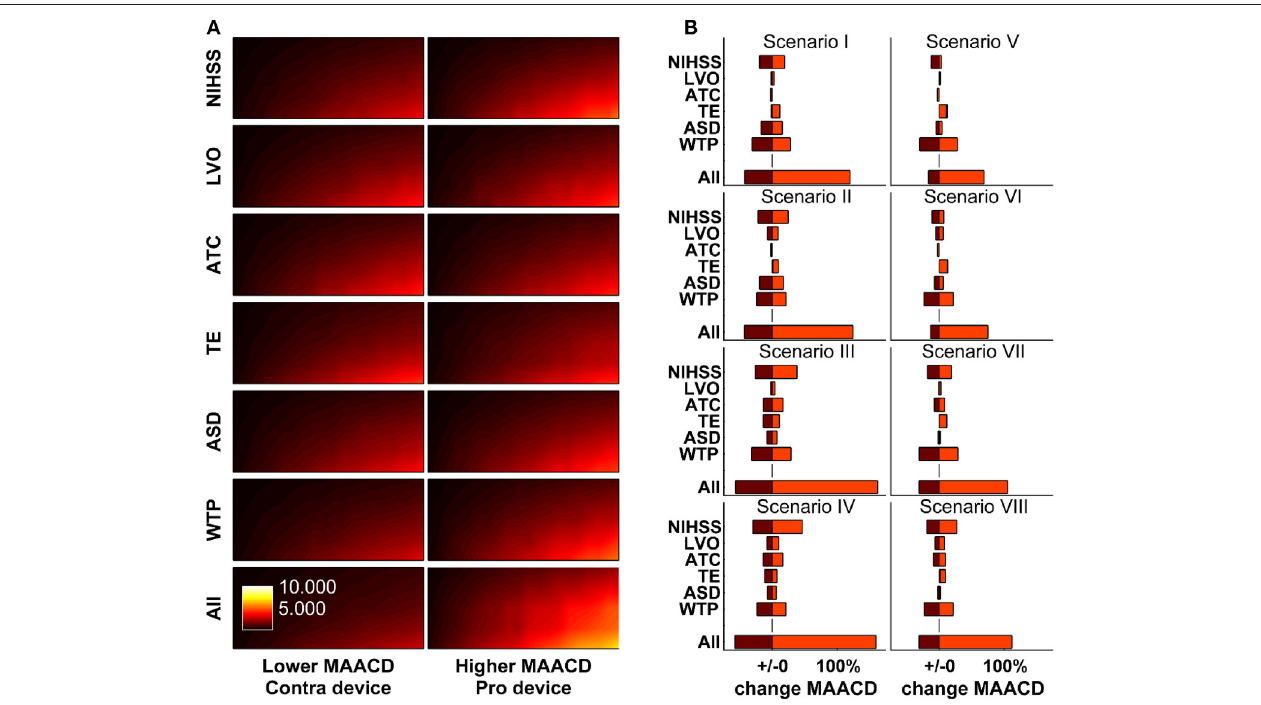
FIGURE 5 | One-way and multi-way sensitivity analyses. Impact of changes of model parameters (distribution of stroke severity, probability of large vessel occlusion as a function of stroke severity, ability to communicate as a function of stroke severity, estimated reduction in disability-adjusted life-years per minute faster treatment as a function of age, sex, stroke severity, and treatment modality [thrombolysis or mechanical thrombectomy], and average sleep duration) on maximally allowable annual cost of device (MAACD) according to age and annual risk of ischaemic stroke. (A) MAACD according to age and annual risk of ischaemic stroke (base-case socio-geographic scenario). Rows 1–6 show MAACD maps for the contra-device (left hand side) and pro-device (right hand side) values of model parameters indicated on the left. Row 7 shows MAACD maps for multiway sensitivity analyses including all parameters of row 1–6. (B) relative changes of MAACD associated with individual and joint changes of model parameters in socio-geographic scenarios I–VIII. For a definition of socio-geographic, see main text and Table 7 . NIHSS stands for National Institutes of Health Stroke Scale, LVO for large vessel occlusion, ATC for ability to communicate, TE for treatment effect, ASD for average sleep duration, and WTP for willingness-to-pay